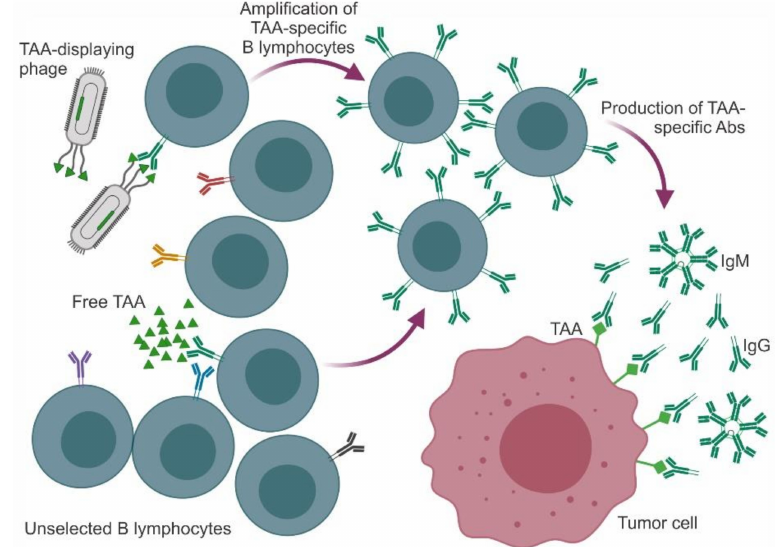
Figure 1. Humoral response: B lymphocytes. Both TAA-mimic peptides and TAA-displaying phage particles are recognized by B lymphocytes, which respond by producing high-a ffi nity, anti-TAA Abs. These Abs are released and enter the bloodstream to reach tumor cells and tag them for neutralization and / or destruction. Abbreviations: TAA, tumor-associated antigens.